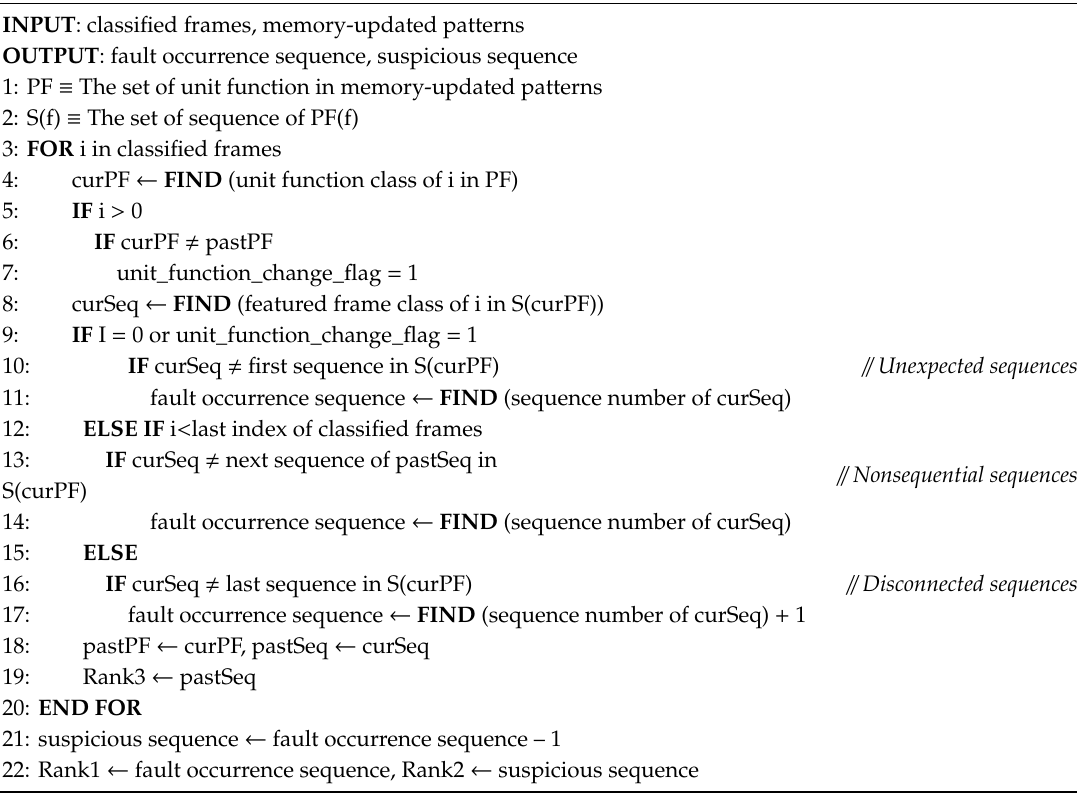
Figure 10. Example of finding the fault occurrence sequence of front turn signal. ( a ) Example; ( b ) fault candidates with the rank. Algorithm 1. The algorithm for determining fault occurrence sequence